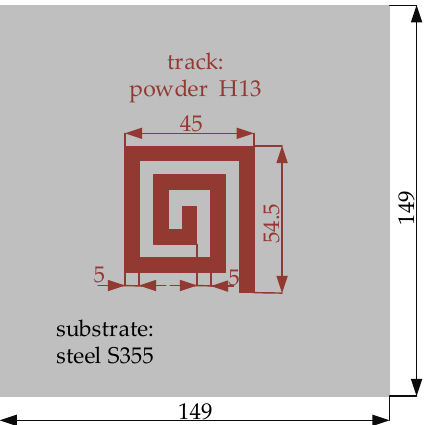
Figure 2. Track to be deposited on the substrate (all dimensions given in mm).